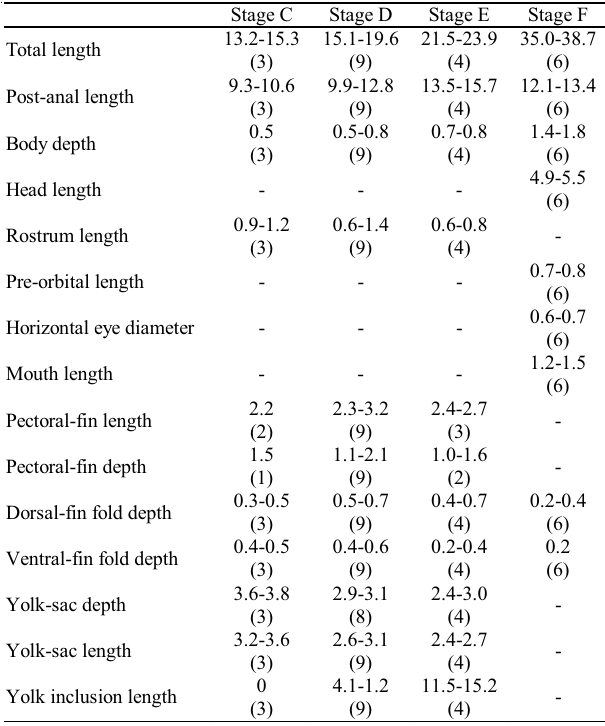
Table 2 . Morphometrics of larval stages of Synbranchus lampreia , MZUSP 84453. All measurements are expressed in mm. Ranges for each measuring are followed by